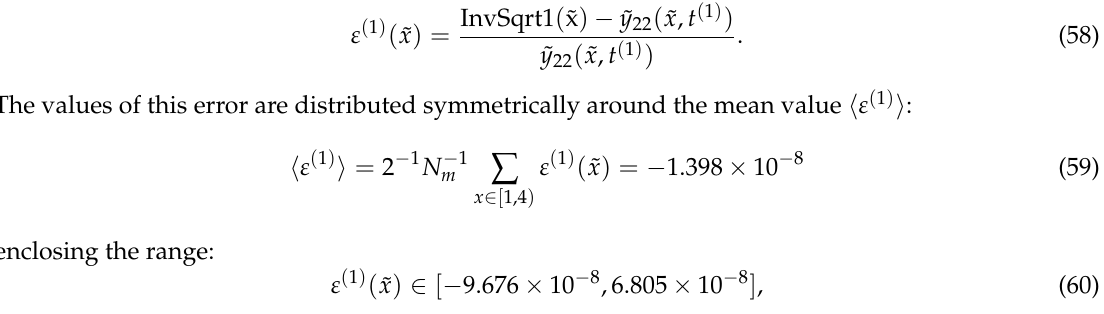
Figure 2. The observed blur can be expressed by a relative deviation of the numerical result from ˜ y 22 ( ˜ x )